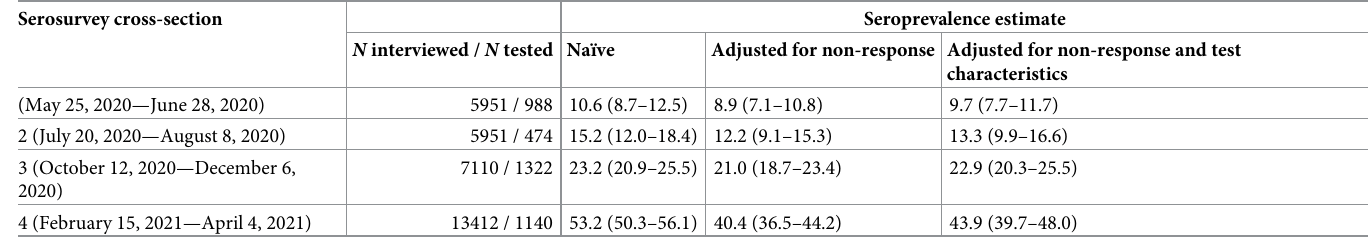
Table 1. Seroprevalence by study cross-section, ELISA Coronapass. Serosurvey cross-section